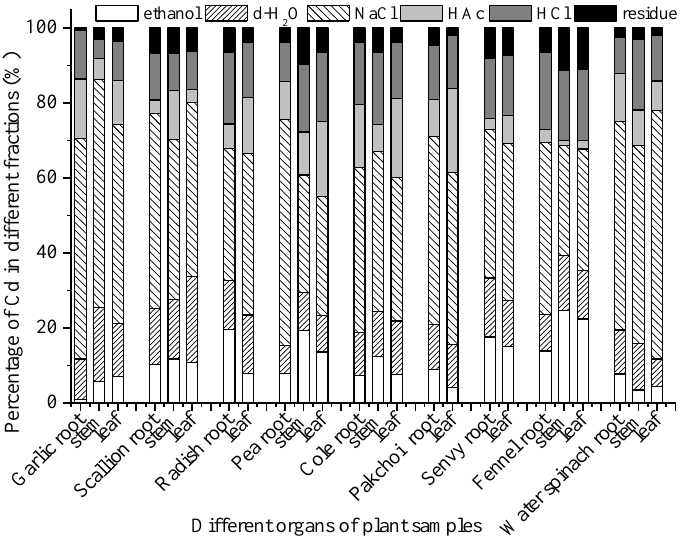
Figure 5. Proportion (%) of Cd associated with different chemical fractions (extracted by 80% ethanol, d-H 2 O, 1M NaCl, 2% HAc, 0.6 M HCl, and residue) in different tissues (root, stem, and leaf) of the nine vegetables (mean, n = 4,